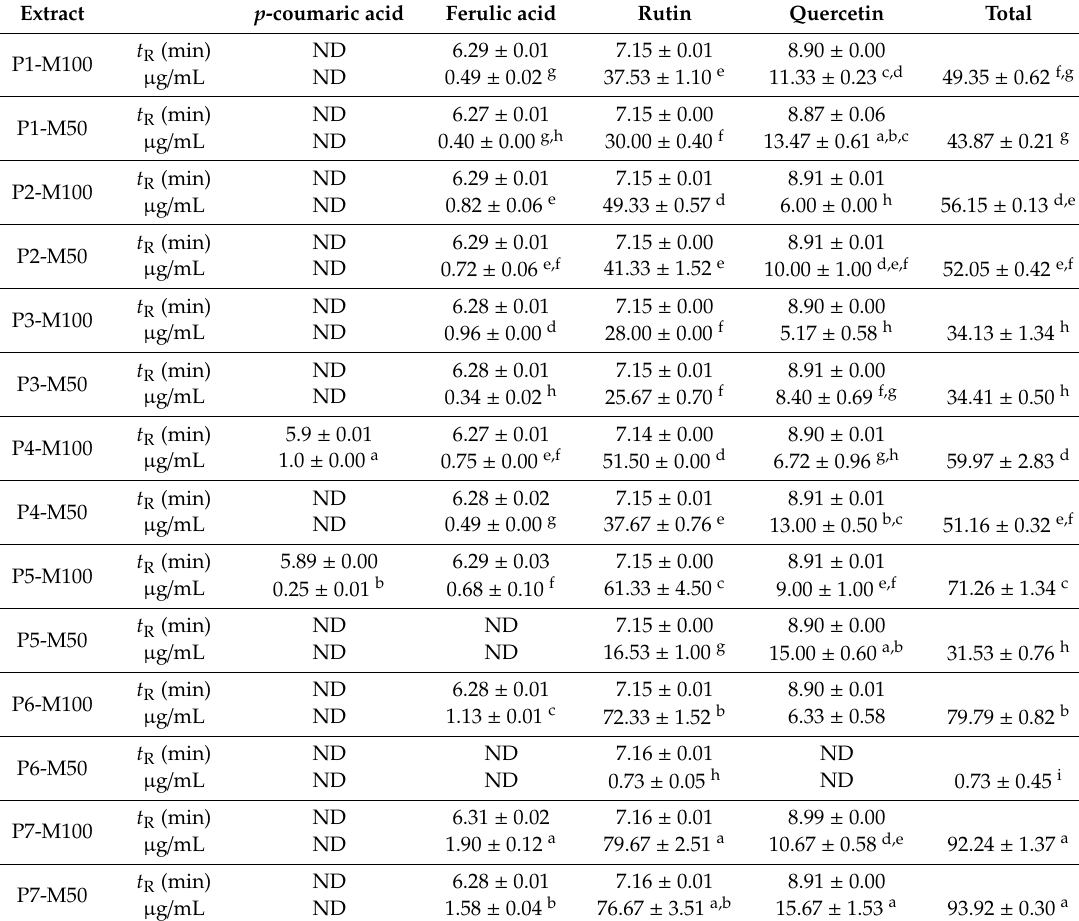
Table 2. Phenolic composition of 50 and 100% methanol extracts of Asclepias linaria leaves identified by ultra-performance liquid chromatography coupled to mass spectrometry (UPLC-MS). Extract p -coumaric